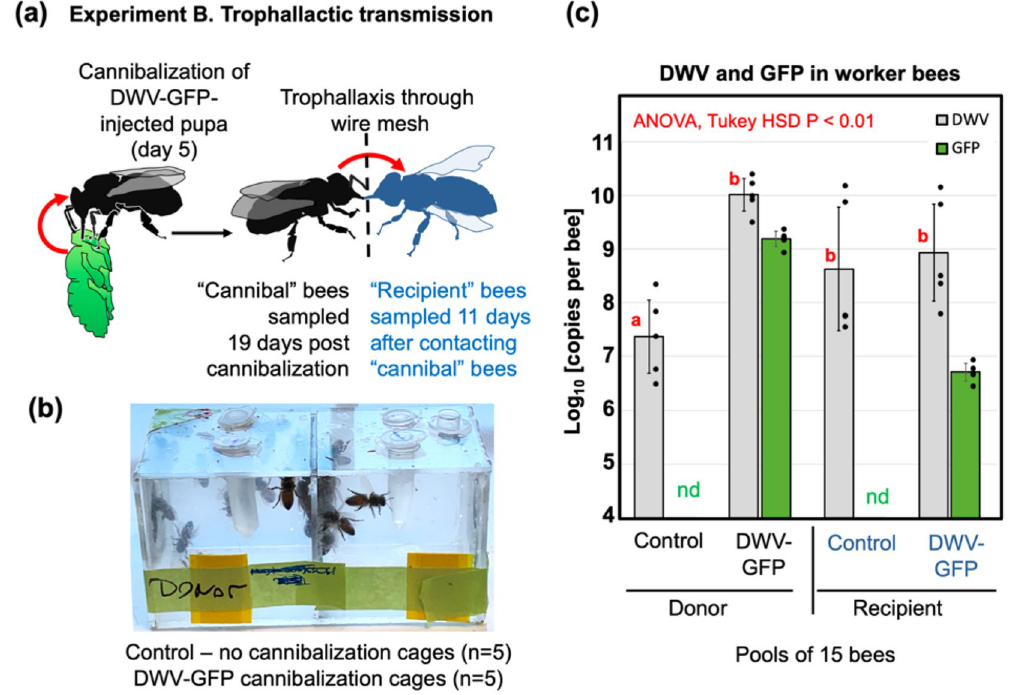
Figure 3. Trophallactic transmission of cannibalized DWV (Experiment B). ( a ) Schematic representation of the experiment. ( b ) Design of the trophallactic cages. ( c ) Average per insect levels of DWV and GFP RNA in the pools of worker bees, error bars indicate standard deviation. For DWV, red letters above bars indicate significantly and non-significantly different groups (ANOVA). Average DWV and GFP copy number in the cage pools are indicated by black dots, nd not detectable